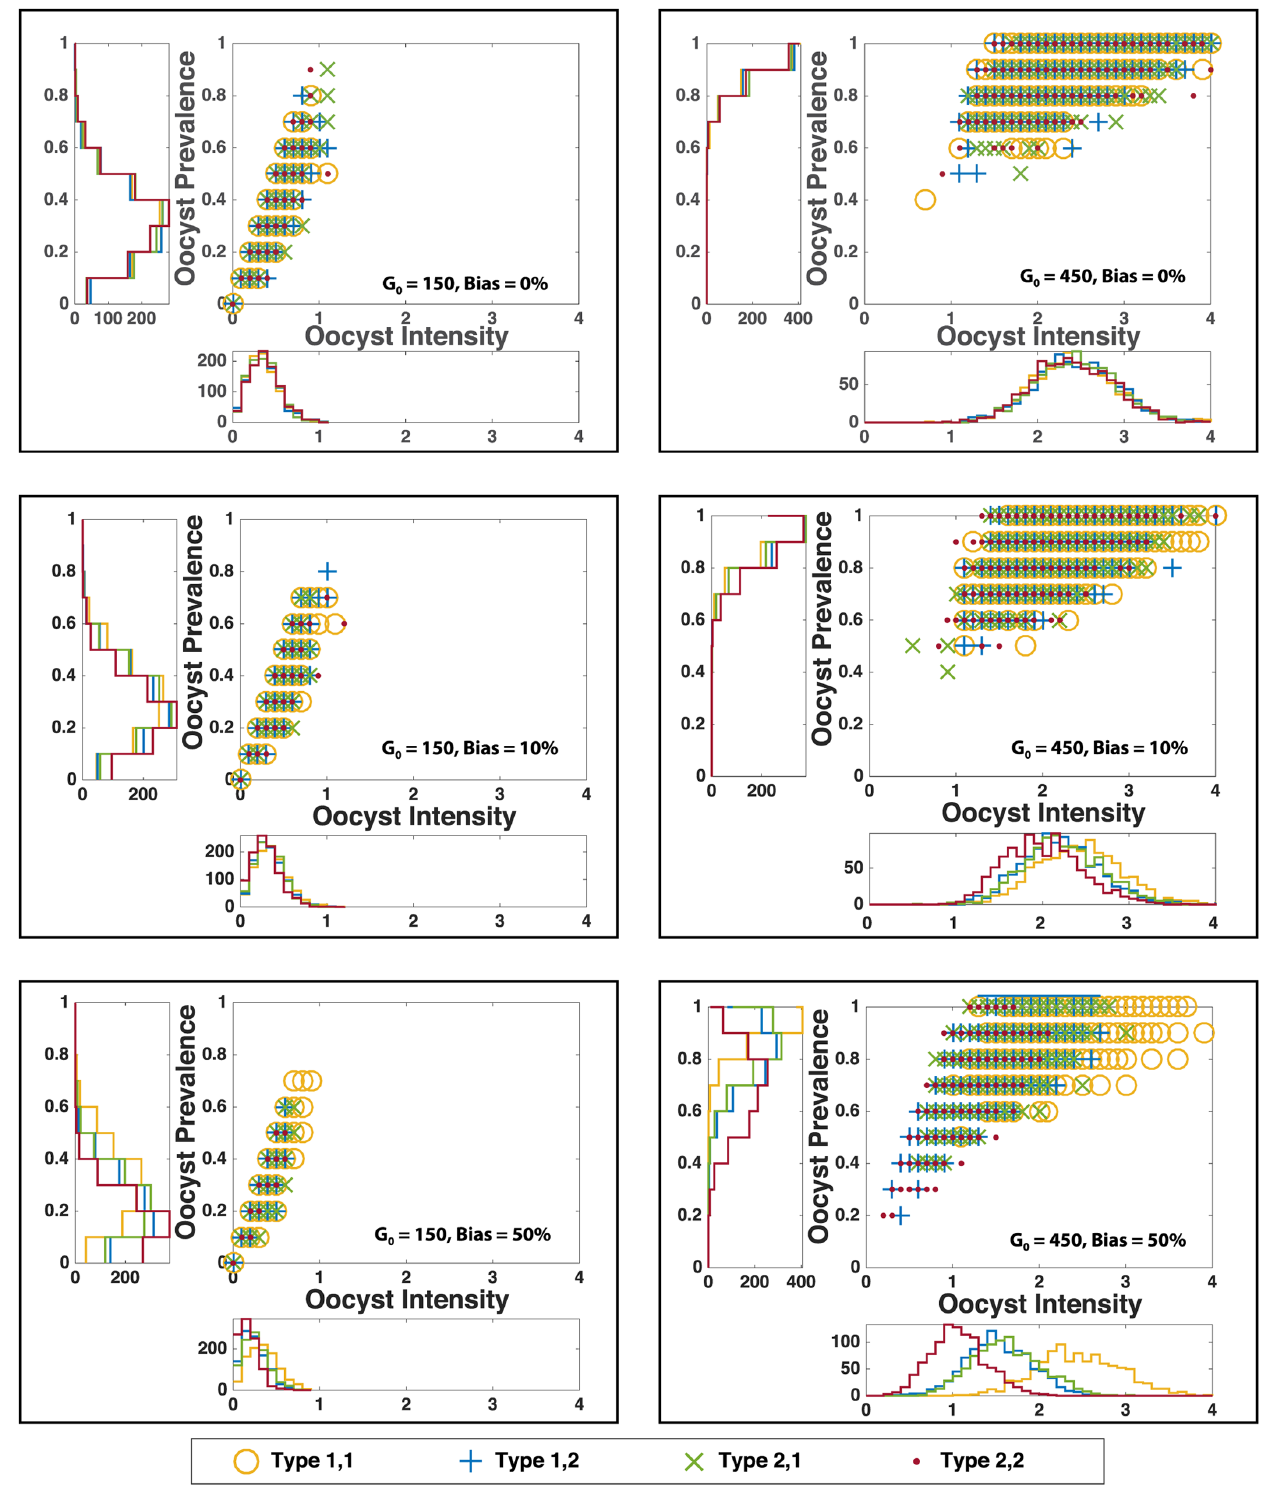
Fig 5. Oocyst intensity and prevalence. The scatter plots show mean oocyst intensity (x-axis) versus mean oocyst prevalence (y-axis), calculated 1000 times. Oocyst prevalence is definedas the proportionof mosquitoesharboringoocysts (i.e. simulations producing at least one oocyst). Oocyst intensity is definedas the number of oocysts per mosquito(i.e. per simulation). To produceeach point, we randomlydrew ten mosquitoes (that is, ten